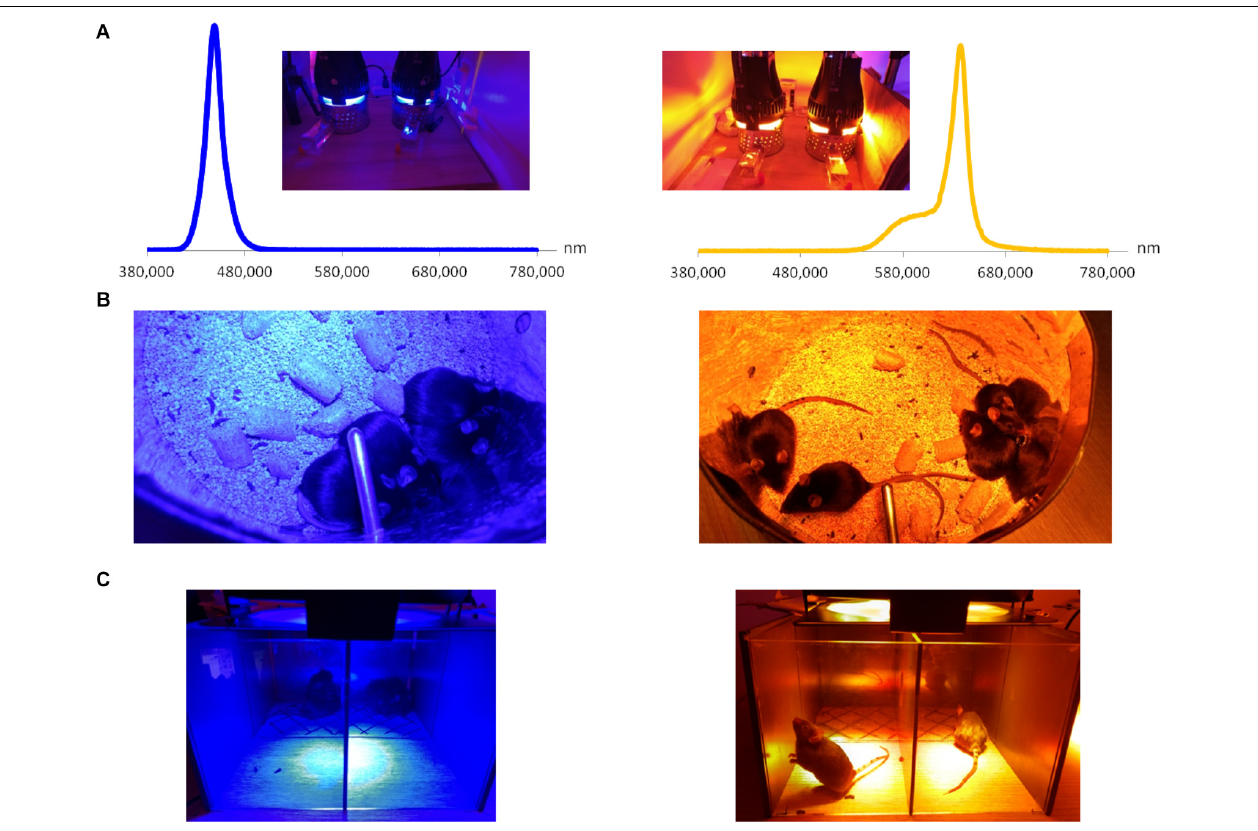
FIGURE 1 | Custom-mounted illumination system. (A) Illumination system and relative spectra of LED sources. (B) When placed together (and not in separate compartments), mice exposed to blue illumination demonstrated light aversion by hiding behind each other; such behavior did not take place for yellow exposure. (C) Behavior test: mice are placed in half-illuminated boxes and allowed to move freely. As in the previous figure, mice exposed to blue illumination demonstrated a strong light aversion, as compared to the yellow one under which animals preferred to